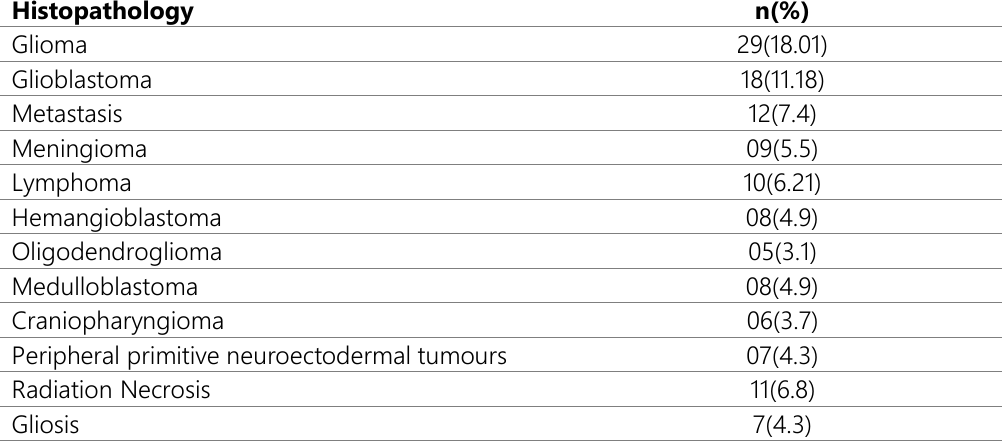
Table 3: Histopathological diagnosis after MR spectroscopy.